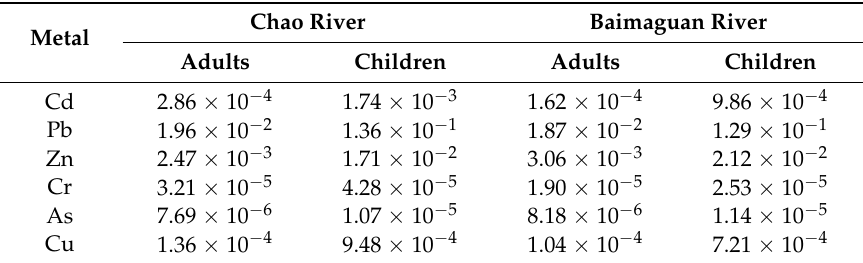
Table 5. The non ‐ carcinogenic risk of Cd, Pb, Zn, Cu and cancer risk of Cr, As in Chao River and Baimaguan River soil.